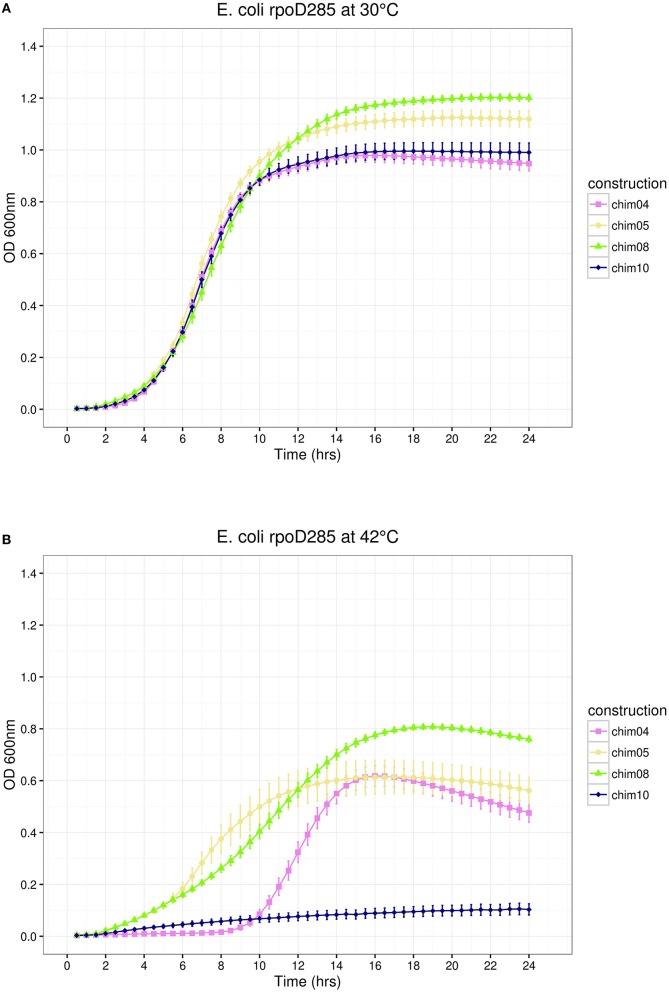
E. coli rpoD285 complementation experiments. pRKch04, violet squares; pRKch05, khaki circles; pRKch08, chartreuse triangles; and pRKch10, dark blue diamonds. (A) Growth temperature: 30°C. (B) Growth temperature: 42°C. Twenty repetitions were done for each construction. Error bars denote SEM.